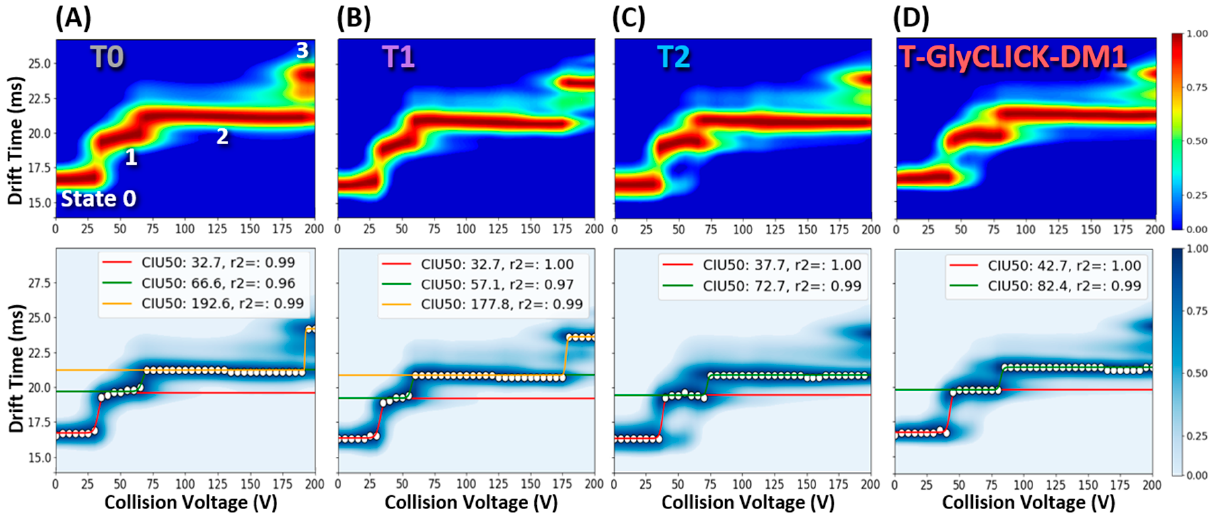
Figure 5. CIU experiments at the intact level for the 24+ charge state. CIU fingerprints (upper panel) and CIU50 analysis (lower panel) were acquired to compare the resistance to gas-phase unfolding of the reaction compounds ( A ) T0, ( B ) T1, ( C ) T2 and ( D ) T-GlyCLICK-DM1.